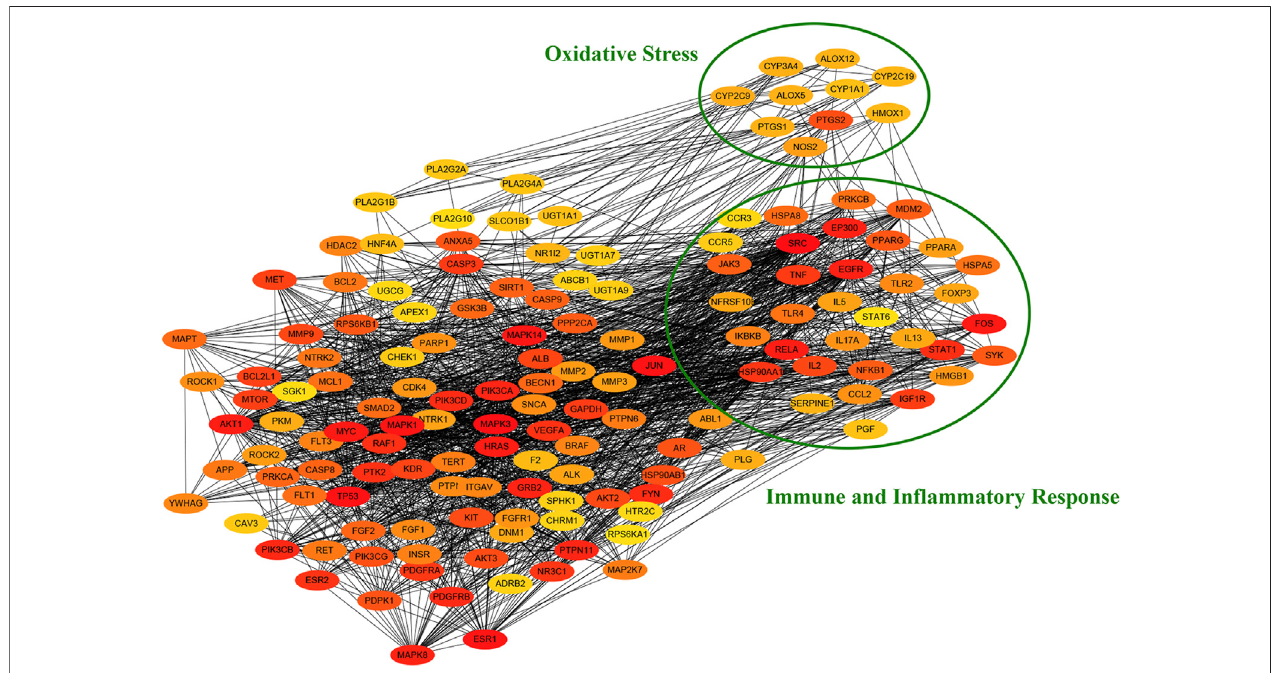
FIGURE 5 | PPI network of potential targets.